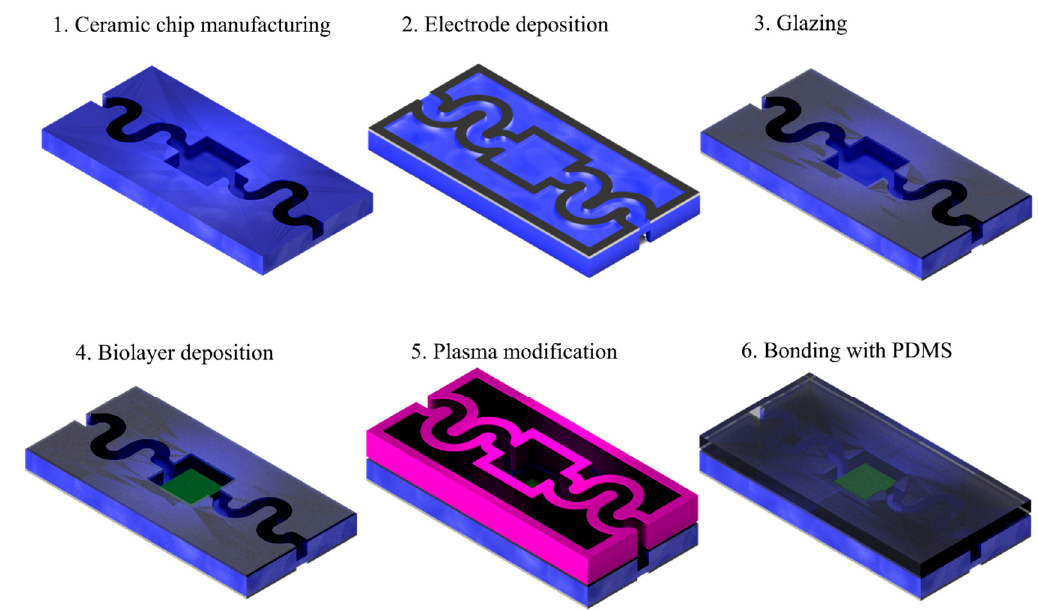
Figure 1. A process diagram of selective low-temperature cofired ceramic (LTCC) / polydimethylsiloxane (PDMS) bonding with biomaterial integration. ( 1 ) A ceramic microfluidic chip is manufactured; ( 2 ) a lower dielectric barrier discharge (DBD) electrode is deposited on the bottom of the chip; ( 3 ) the contact surface is glazed; ( 4 ) the biolayer is deposited inside the microfluidic chamber; ( 5 ) the contact surface is selectively modified using plasma, which appears only above the bottom electrode; ( 6 ) the plasma-modified PDMS is brought into contact with the modified surface and starts to bond with the glazed surface.